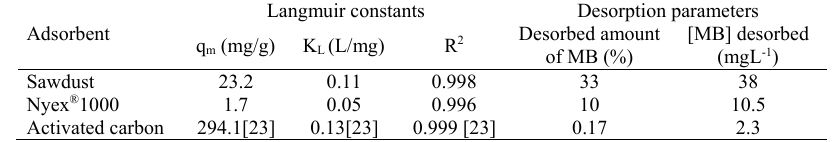
Table 1: Comparison of Langmuir constants and desorption parameters for adsorption of methylene blue onto sawdust, Nyex ® and activated carbon at 303 K. Adsorbent